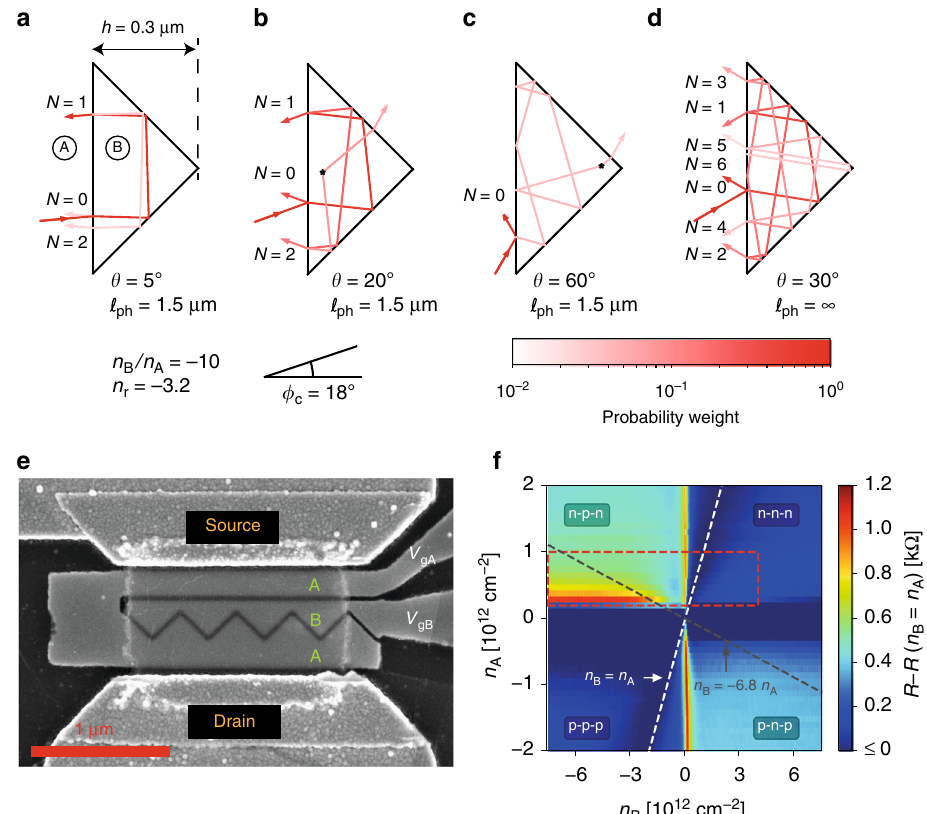
Fig. 1 The corner re fl ector. a – d Calculated trajectories in a corner re fl ector with a critical angle ϕ c = 18°, corresponding to a doping ratio of 10 between the regions A and B . At low incidence angle, the probability of the fermion to be re fl ected after one round trip is close to unity. When the incidence angle is slightly oblique, fermions have a high probability of staying trapped within the prism for multiple round-trips, and become susceptible to phonon scattering, which helps them escape the prism. At high incidence angle, the probability of being re fl ected before entering the prism is close to unity. e Annotated SEM micrograph of the device (sample CR-H9.4). Two bottom gates V gA and V gB allow for local control of the DFO refractive index in the access ( A ) and barrier ( B ) regions. hBN-encapsulated graphene is visible as a transparent rectangle, contacted at the edge by source and drain electrodes. f Color plot of the device resistance as a function of the charge carrier densities in regions A and B . The shading of the four quadrants is typical for a double-junction: low resistance (dark blue) in the unipolar quadrants and higher resistance (light blue) in the bipolar quadrants. The resistance minimum R ( n A = n B ) (contact resistance) was subtracted from the data. The white dashed line indicates n A = n B , consistent with the resistance minimum, whereas the black dashed line indicates n B = − 6 n A , the criterion for total internal re fl ection. In the following we will focus on the data within the red dashed